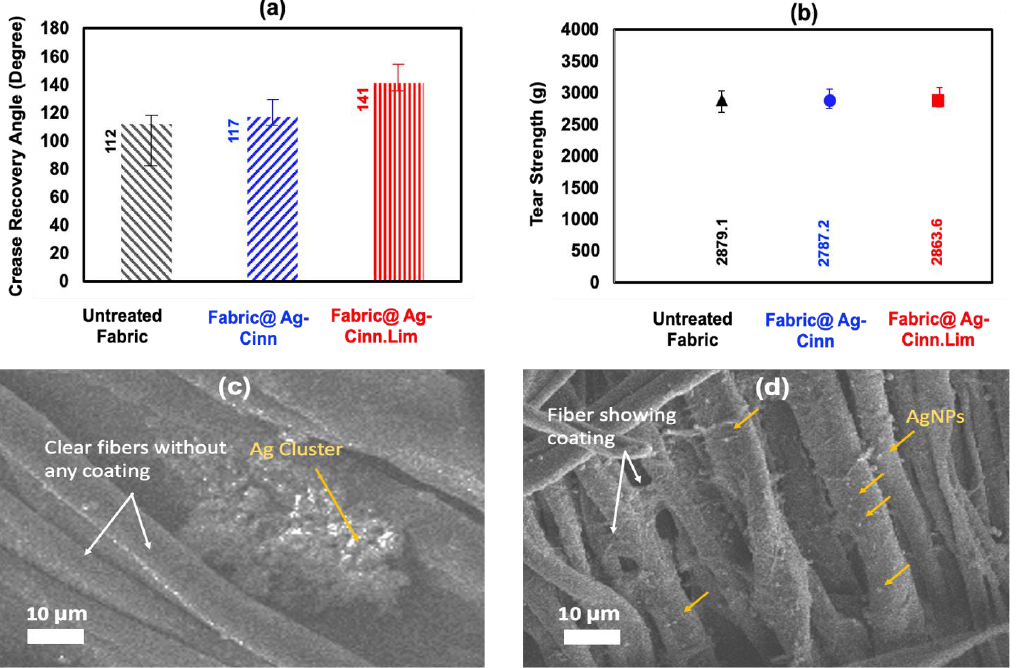
Figure 7. Measurement of fabric easy-care performance and tear strength as an impedance of crosslinking: ( a ) comparison of crease recovery angle value; ( b ) comparison of crease recovery angle value; ( c , d ) SEM images of fabric treated with Ag@CINN and Ag@CINN-Lim, respectively (yellow arrows point out the nanoparticles whereas white arrows point out the textile fibers).